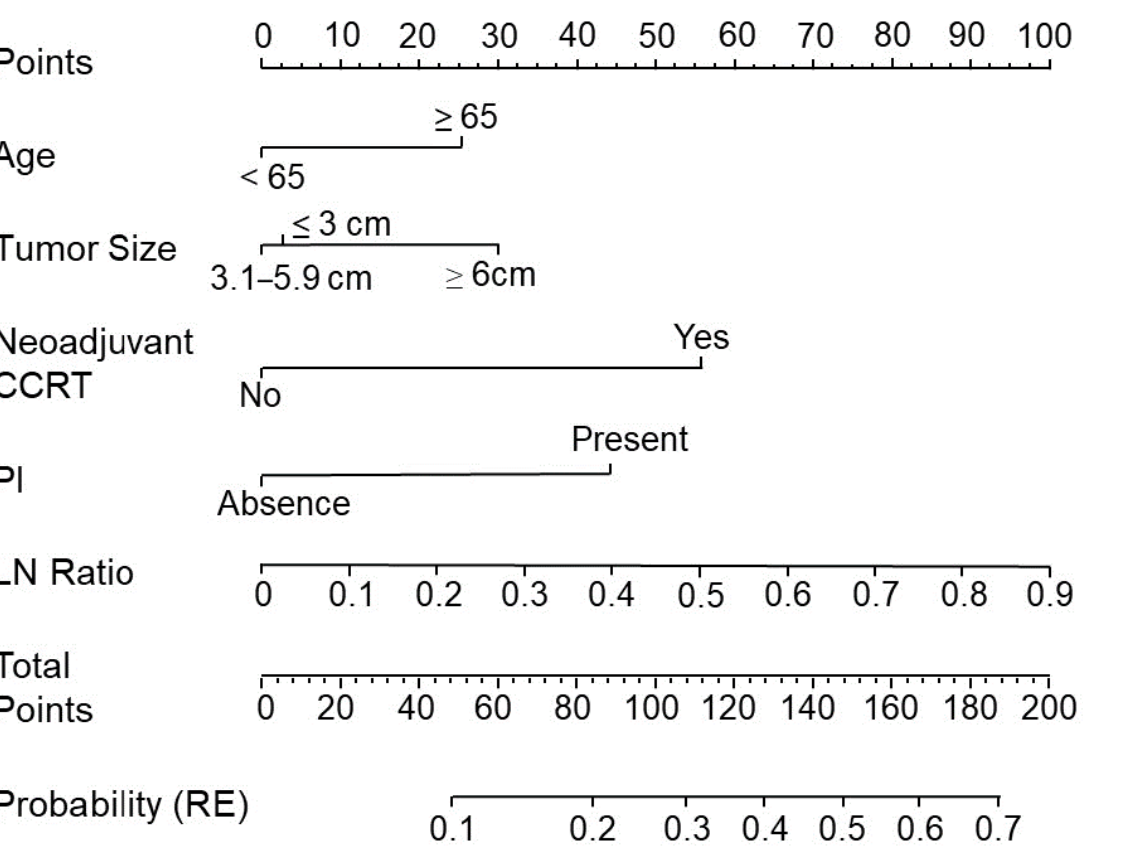
Figure 3. An established nomogram for predicting cancer recurrence. Nomogram incorporating clinical and pathological factors for predicting recurrence in patients with resected stage II–III CRC. There were five prognostic factors: age, tumor size, neoadjuvant chemoradiotherapy (CCRT), perineural invasion (PNI), and lymph node ratio (LNR). A straight line was drawn up to the points axis to determine how many points were associated with recurrence (RE). This process was repeated for each prognostic factor. The total points received for each prognostic factor are shown. From this, we calculated the probability of RE. Table 3. Univariable and multivariable analyses of variables associated with recurrence-free